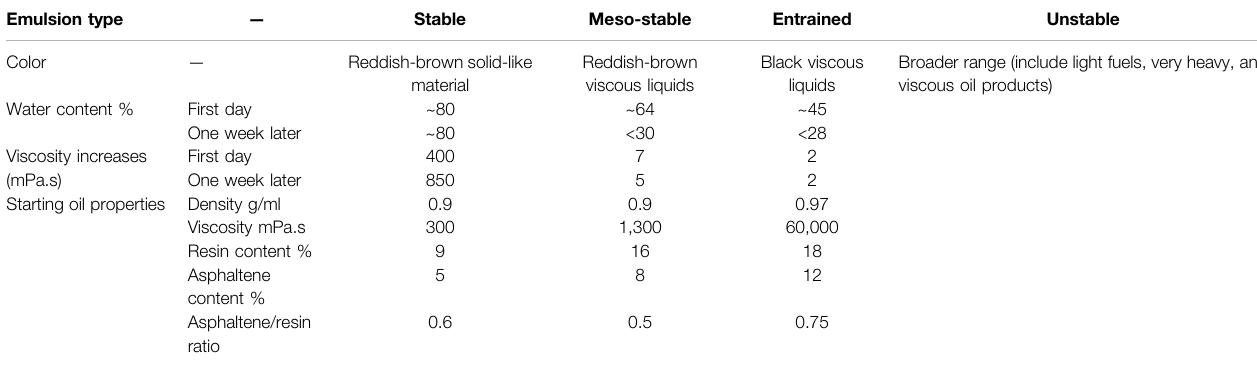
TABLE 4 | Characteristics of four emulsion types (Fingas, 2010). Emulsion